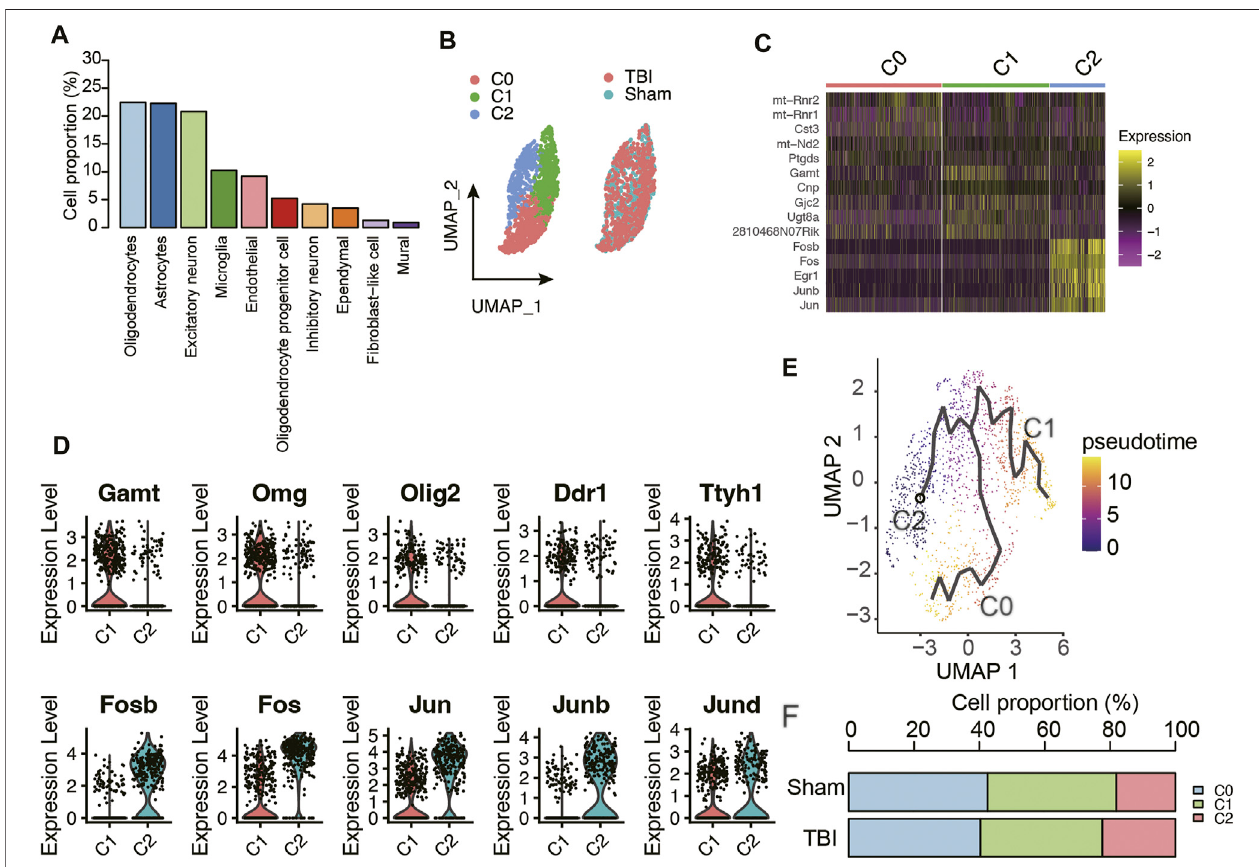
FIGURE 2 | The molecular characteristics of oligodendrocyte subpopulations. (A) The proportion of cell types in the mouse hippocampus samples. (B) The sub- clustering analysis of oligodendrocytes. (C) The top-5 differentially expressed genes of the three oligodendrocyte subpopulations. (D) The marker genes of oligodendrocyte C1andC2subpopulations. (E) Thetrajectoryanalysisoftheoligodendrocyte subpopulations. (F) Theproportion ofoligodendrocyte populations inTBI and Sham